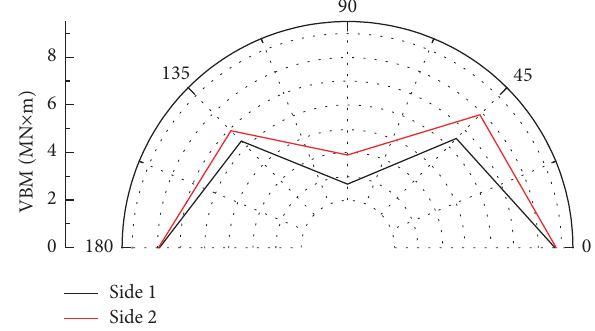
Figure 25: VBM of side hull in difference azimuths.